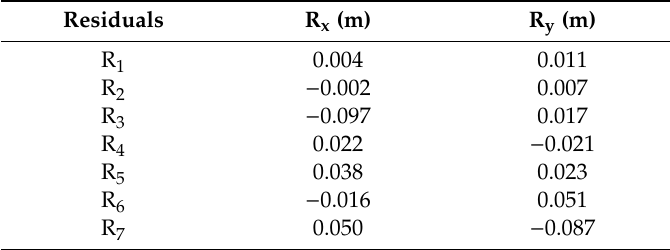
Table A7. Residual values of a ffi ne transformation.